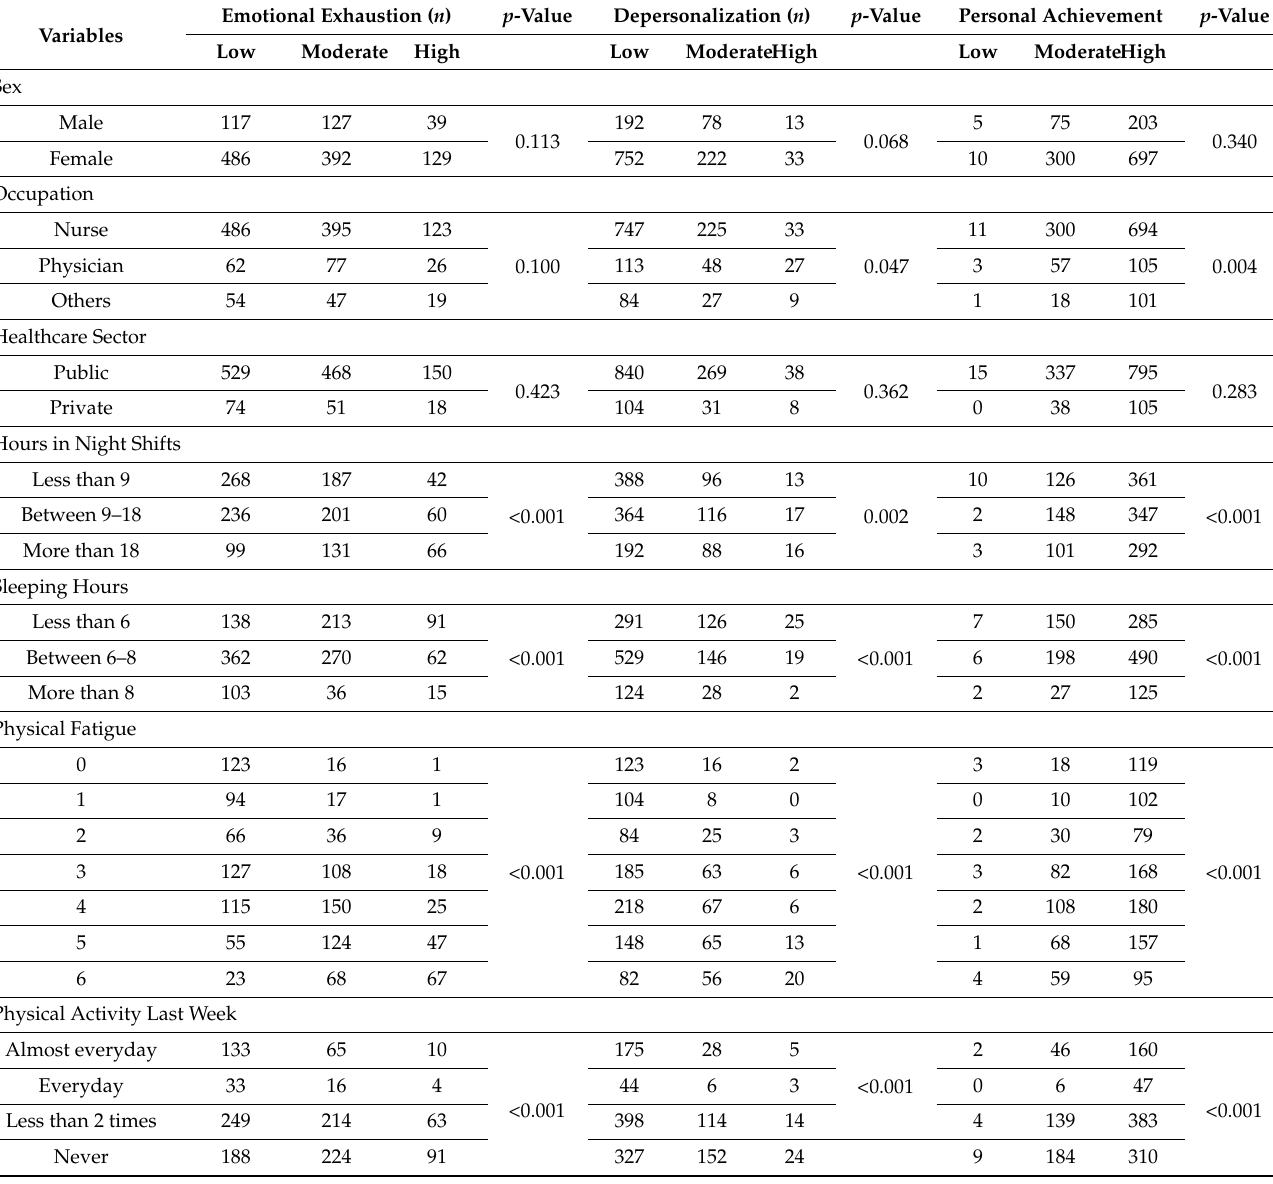
Table 4. Scores of burnout, per domain, among healthcare